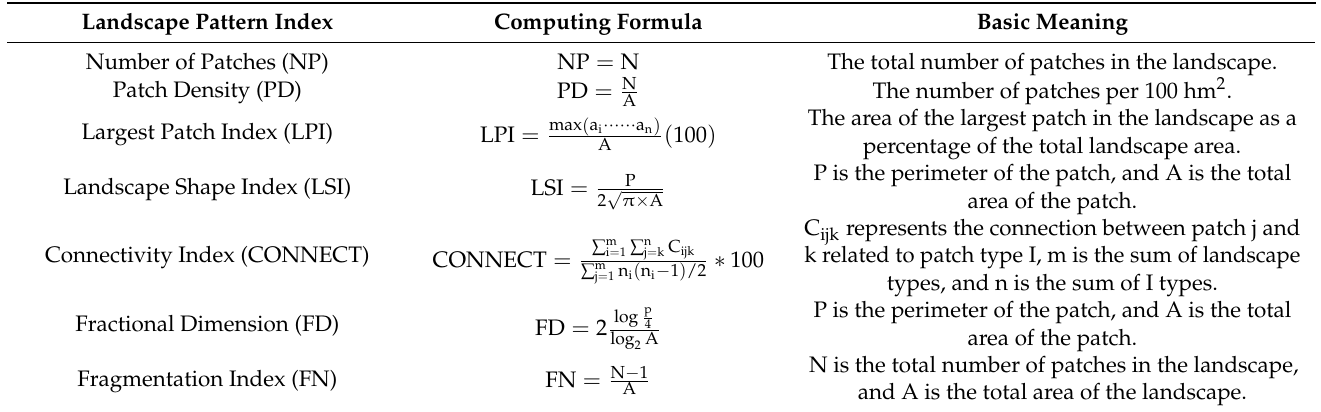
Table 2. Computational method and basic meaning of landscape pattern